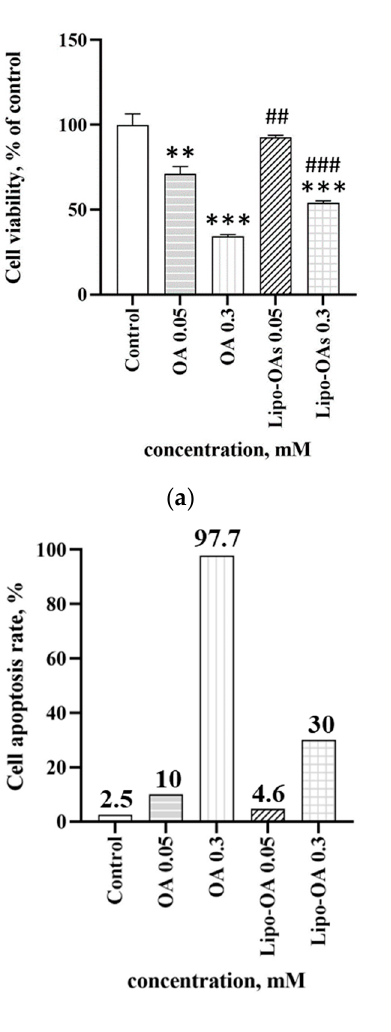
Figure 2. ( a ) MTT assay for OA and Lipo-OAs cytotoxicity; ( b ) Effects on LX-2 cell morphology monitored through light microscopy (magnification, 100×); ( c ) Flow cytometry assay for apoptosis in LX-2 cells treated with OA and Lipo-OAs at various concentrations. ** p < 0.01, *** p < 0.001 compared with control group. ## p < 0.01, ### p < 0.001 compared with OA. Solvent control: DMSO solution that used to dissolve OA.